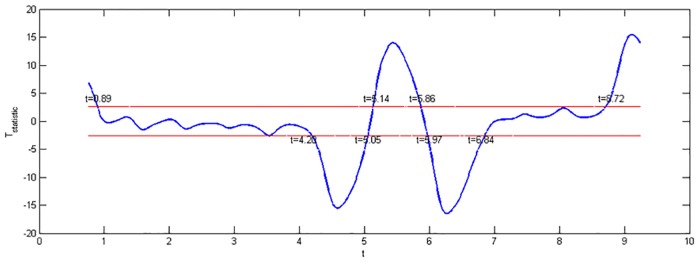
Statistics Tstatistics.